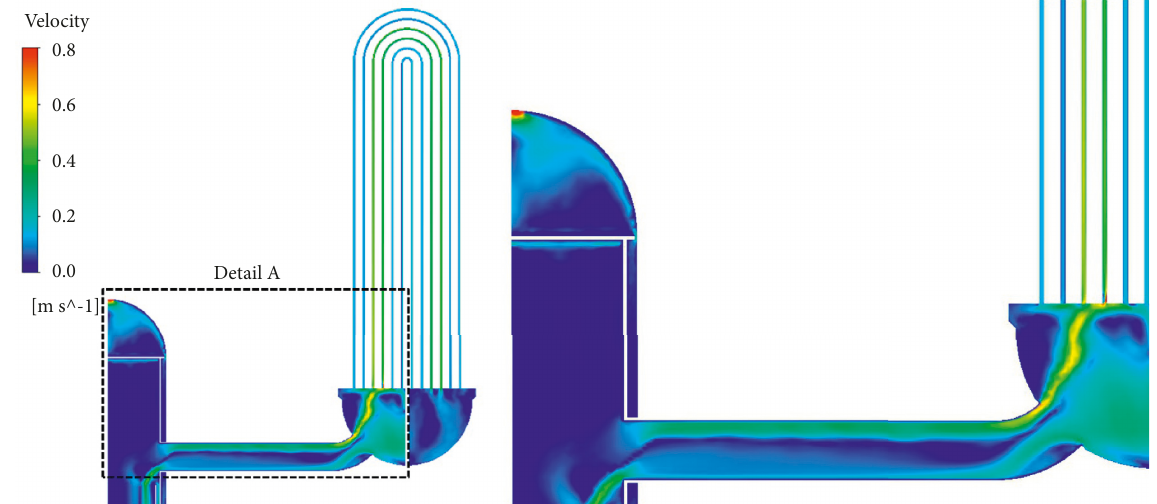
Figure 5: Velocity distribution on symmetry plane (model